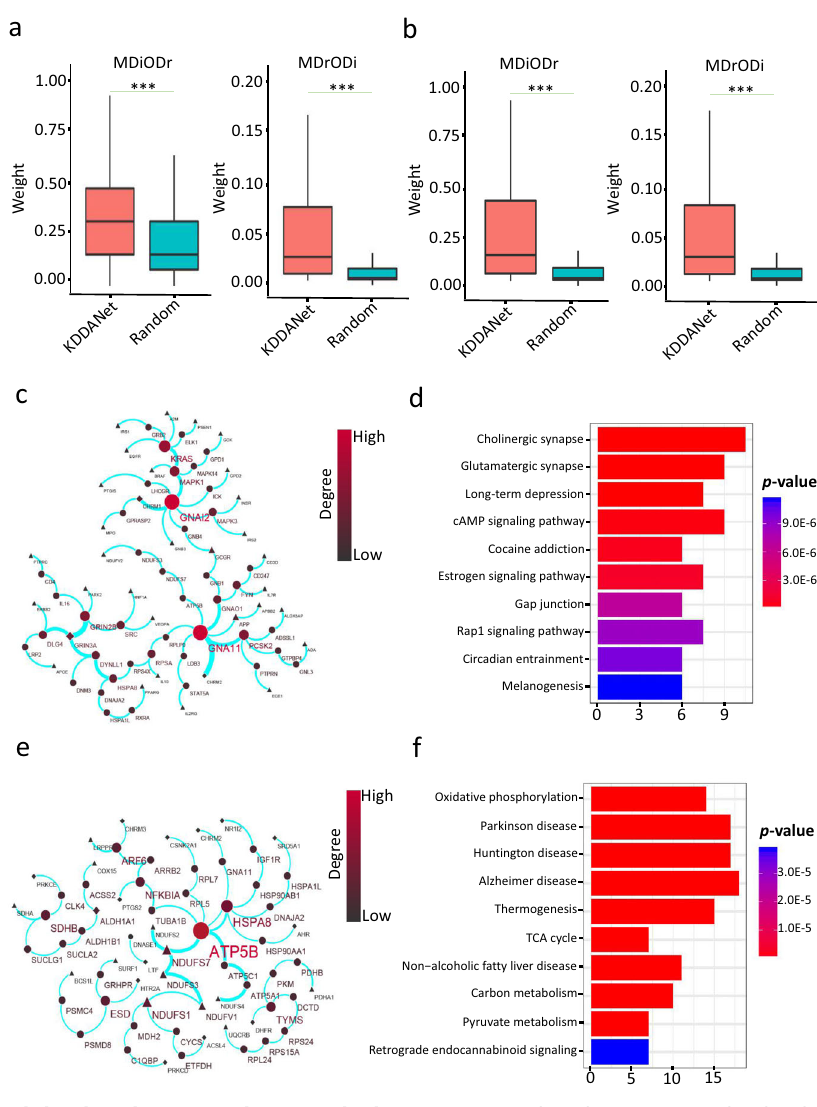
Fig. 5 KDDANet uncovered the shared genes mediating multiple KDDAs. a Boxplots demonstrating the distributions of weight values in KDDANet meta-subnetwork and random meta-subnetwork for MDiODr and MDrODi in SDrTDi context, *** p value < 0.001, calculated by Wilcox signed rank test. b Boxplots demonstrating the distributions of weight values of KDDANet meta-subnetwork and random meta- subnetwork for MDiODr and MDrODi in SDiTDr context, *** p value < 0.001, calculated by Wilcox signed rank test. c Shared meta-subnetwork mediating profenamine (DB00392)-neurological disease associations. d Top ten enriched KEGG terms of shared meta-subnetwork genes mediating profenamine-neurological diseases associations. e Shared meta-subnetwork mediating the associations between